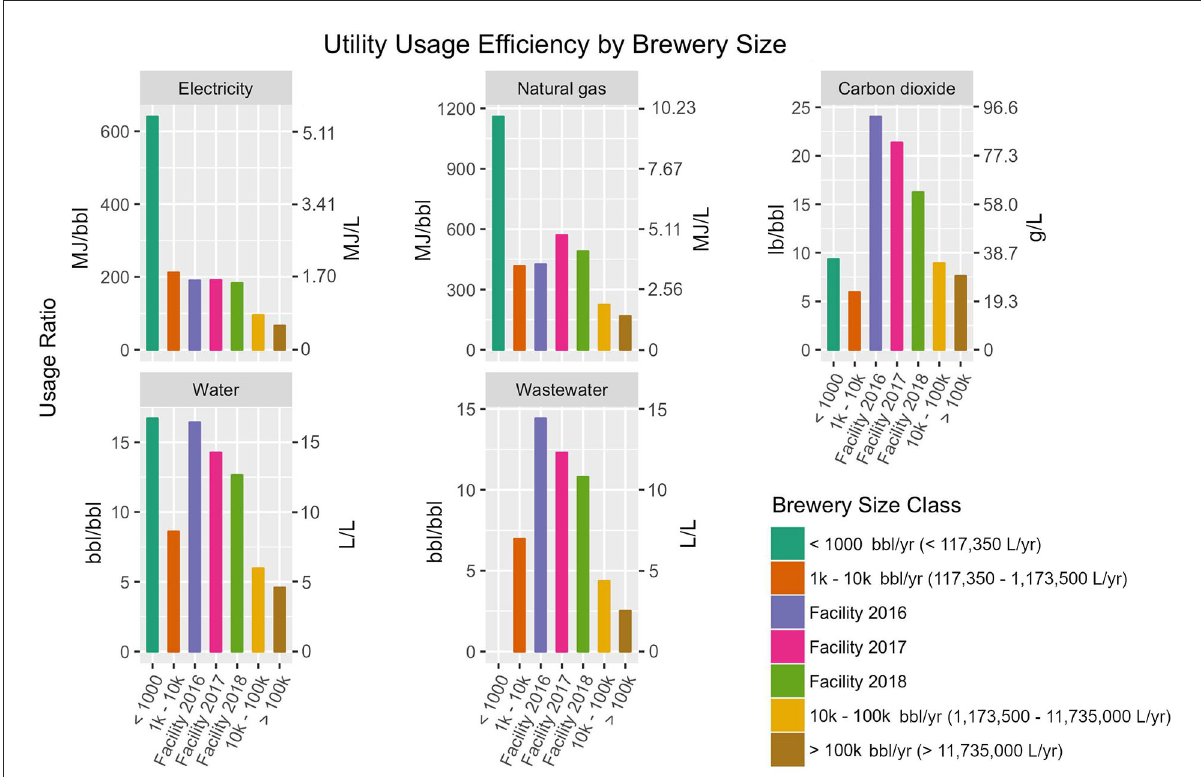
FIGURE4 Specific resource consumption for electricity (e el , MJ/bbl, and MJ/L), natural gas (e th , MJ/bbl, and MJ/L), water (v w , bbl/bbl, and L/L), wastewater discharged (v ww , bbl/bbl, and L/L), and CO 2 (lb/bbl and g/L) [Data are not available for the mass of solid waste disposed at the case study facility. All usage ratios are per bbl packaged or per L packaged. Brewery historical usage ratios are placed between benchmark groups according